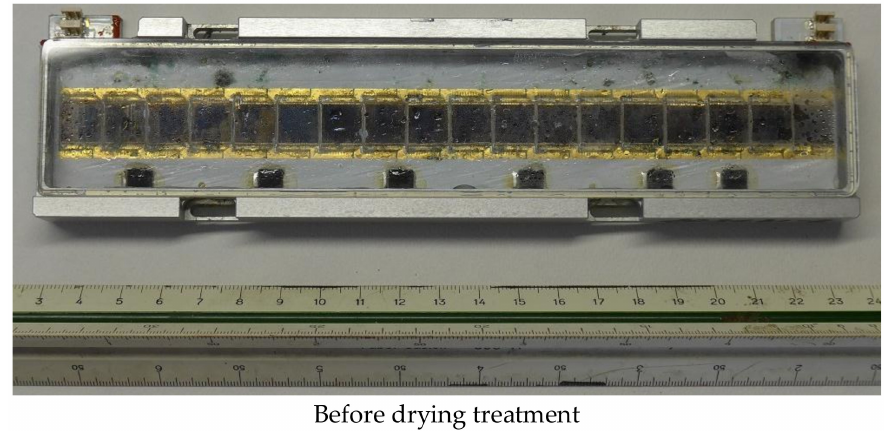
Figure 10. Module 203g71-2 before and after the dehumidification treatment.